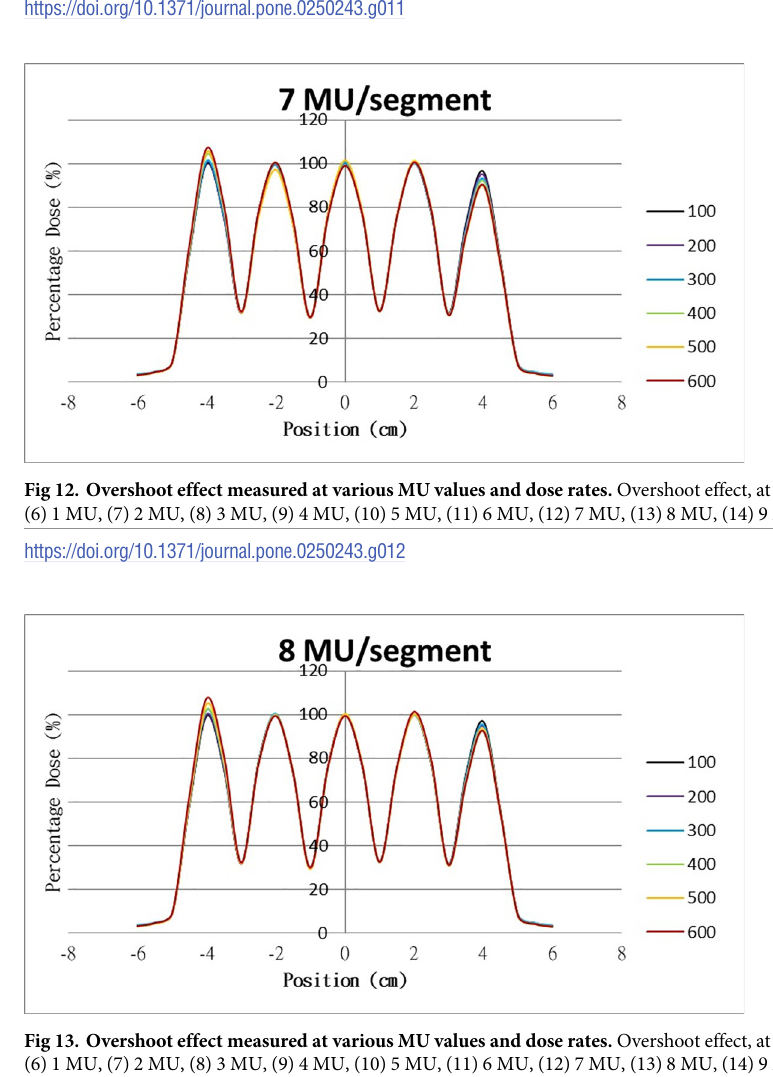
PLOS ONE | https://doi.org/10.1371/journal.pone.0250243 April 23,